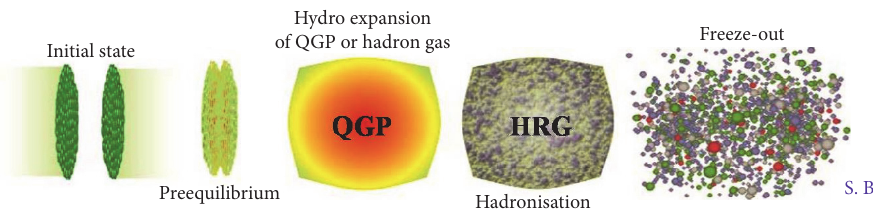
Figure 2: Various stages of ultrarelativistic heavy-ion collisions